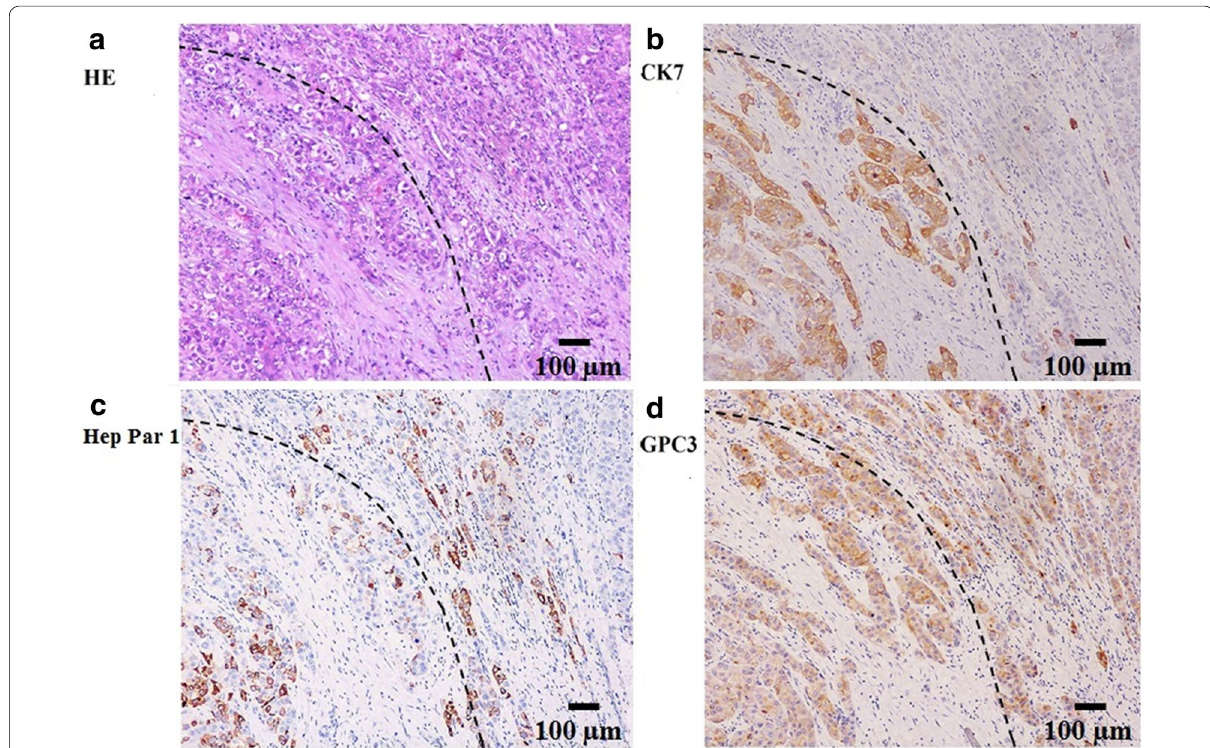
Fig. 2 Representative HE‑stained CHC sections and immunohistochemical staining for Hep Par 1, GPC3, and CK7. Dotted line indicates the bound‑ ary between HCC and ICC components. a Malignant glandular structures ( left part ) and solid sheets of hepatocytes ( right part ) merging into one another (HE). b CK7 immunostaining results in hepatocytes and biliary tissues. c Hep Par 1 immunostaining for hepatocytes and biliary structures. d GPC3 immunostaining for hepatocytes and biliary structures. HE hematoxylin and eosin, Hep Par 1 hepatocyte paraffin 1, GPC3 glypican 3, CK7